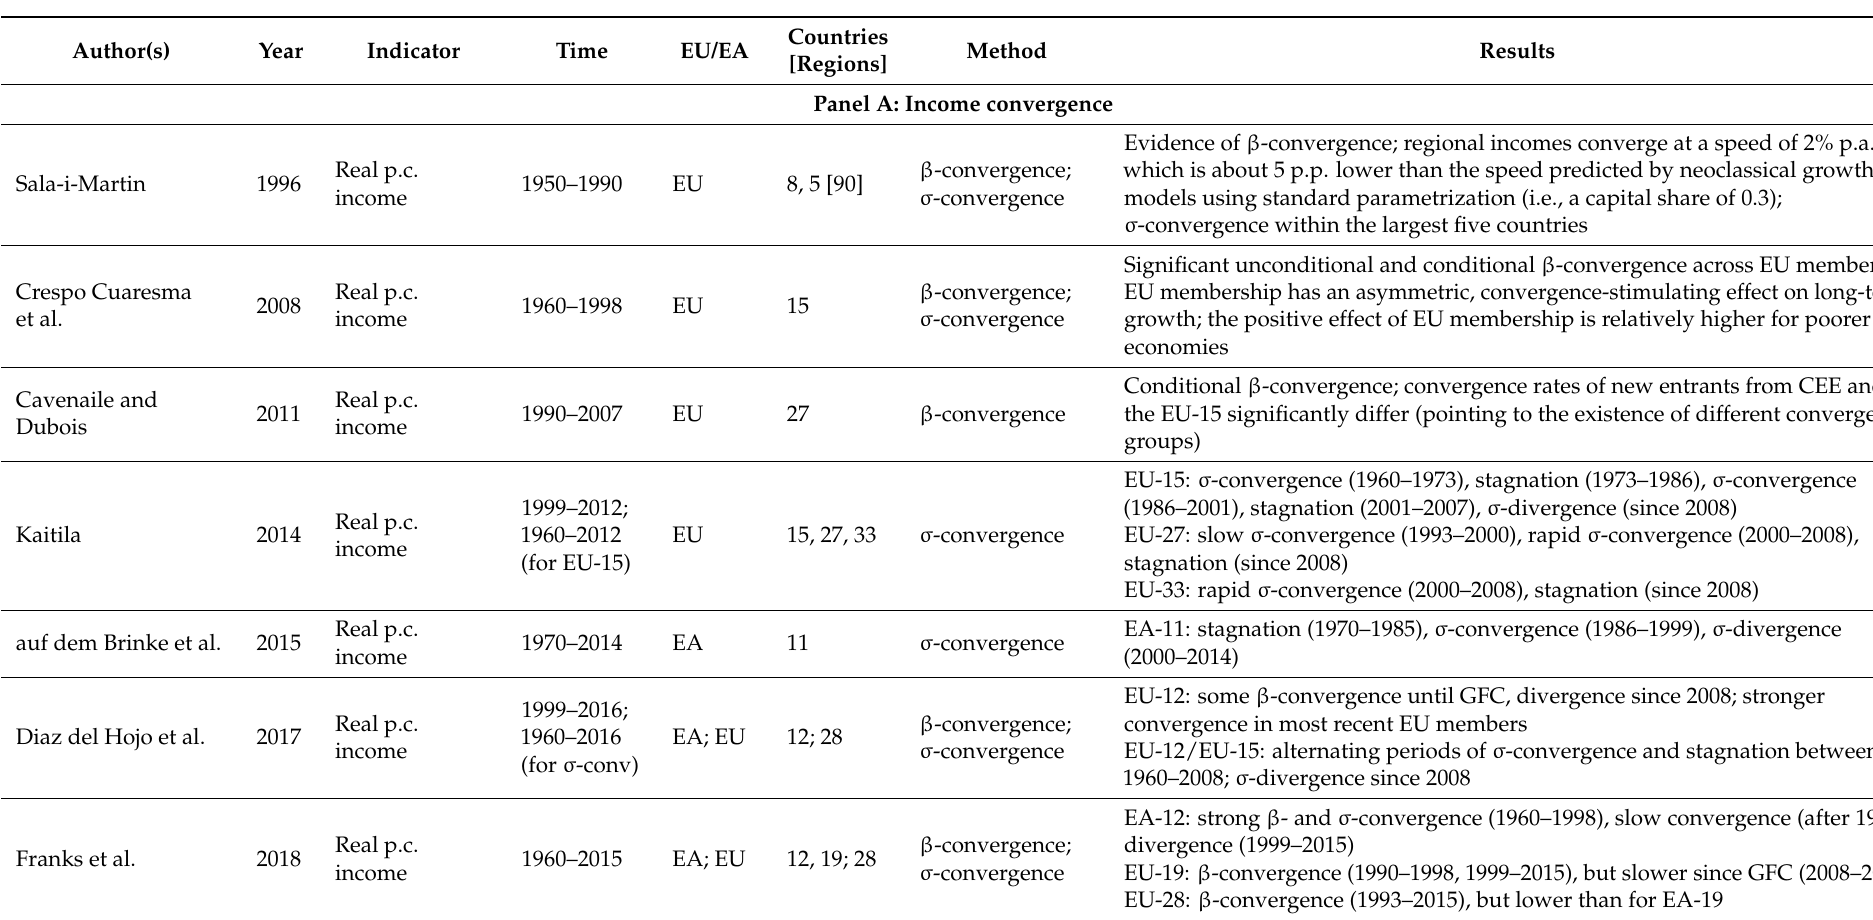
Table 1. Empirical studies on real, nominal, and institutional